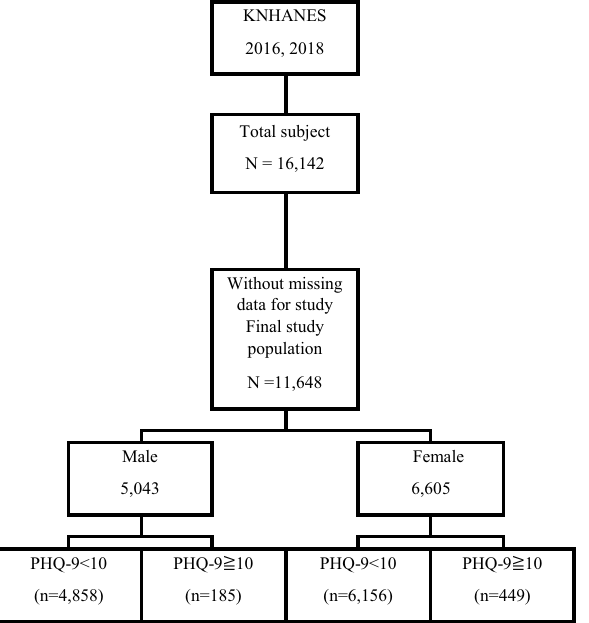
Figure 1. Flow diagram of the participants. PHQ-9 Patient Health Questionnaire-9, KNHANES Korea National Health and Nutrition Examination